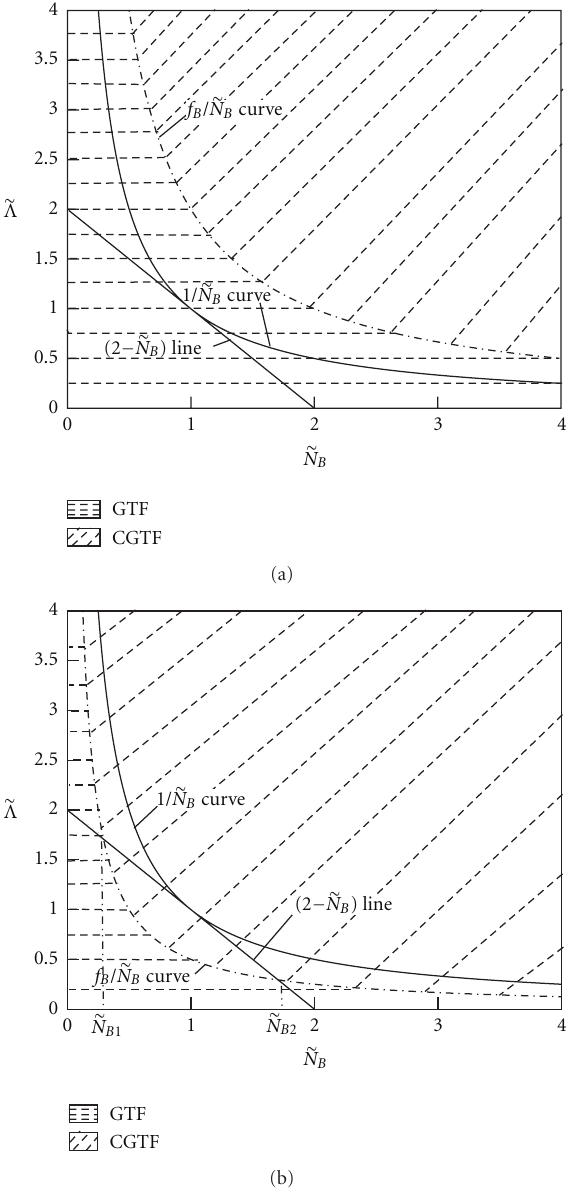
Figure 2: Domain of existence in the ( (cid:2) Λ , (cid:2) N B ) plane of gradient or counter-gradient total turbulent flux at the products side (a) case > 1 and (b) case f < 1.